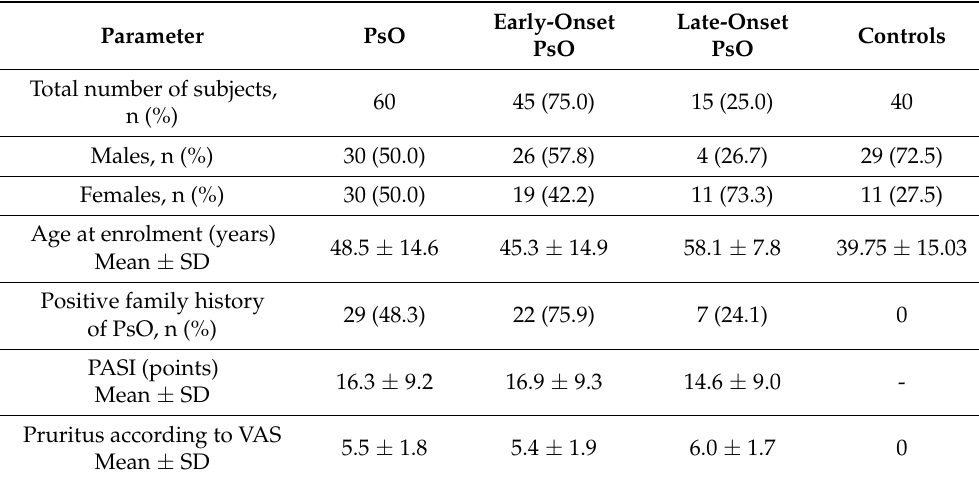
Table 2. Characteristics of the PsO and control